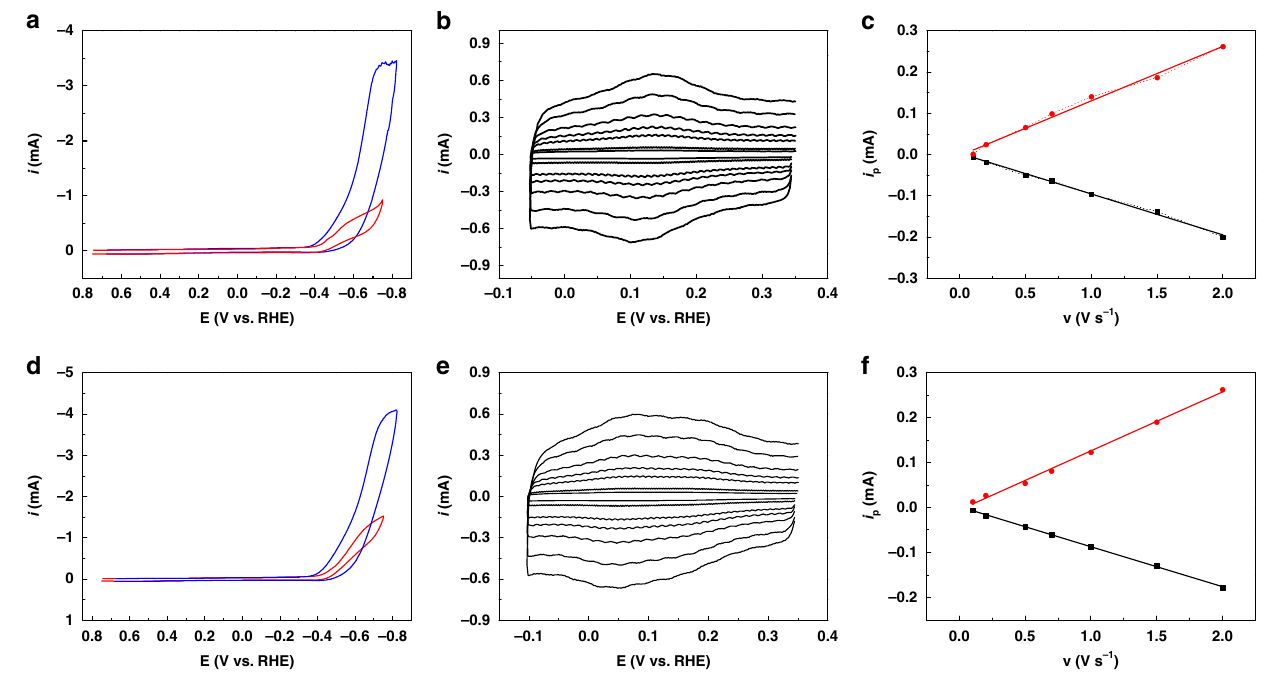
Fig. 2 Cyclic voltammetry of cobalt phthalocyanine catalytic fi lms. Top a – c CoPc1 @MWCNTs, bottom d – f CoPc2 @MWCNTs. a , d CV of a cobalt phthalocyanine catalytic fi lm deposited onto a glassy carbon electrode ( d = 3 mm) in 0.5 M NaHCO 3 at v = 0.1 V s − 1 under argon (red, pH 8.5) and CO 2 (blue, pH 7.3). b , e CV at various scan rates of the Co II /Co I wave under argon atmosphere. c , f Variation of the peak current vs. scan rate for the Co II /Co I redox wave. A redox active catalyst concentration of Γ = 1.45 ± 0.12 nmol cm − 2 was obtained from i p = n 2 F 2 vS Γ /4 RT for both catalysts